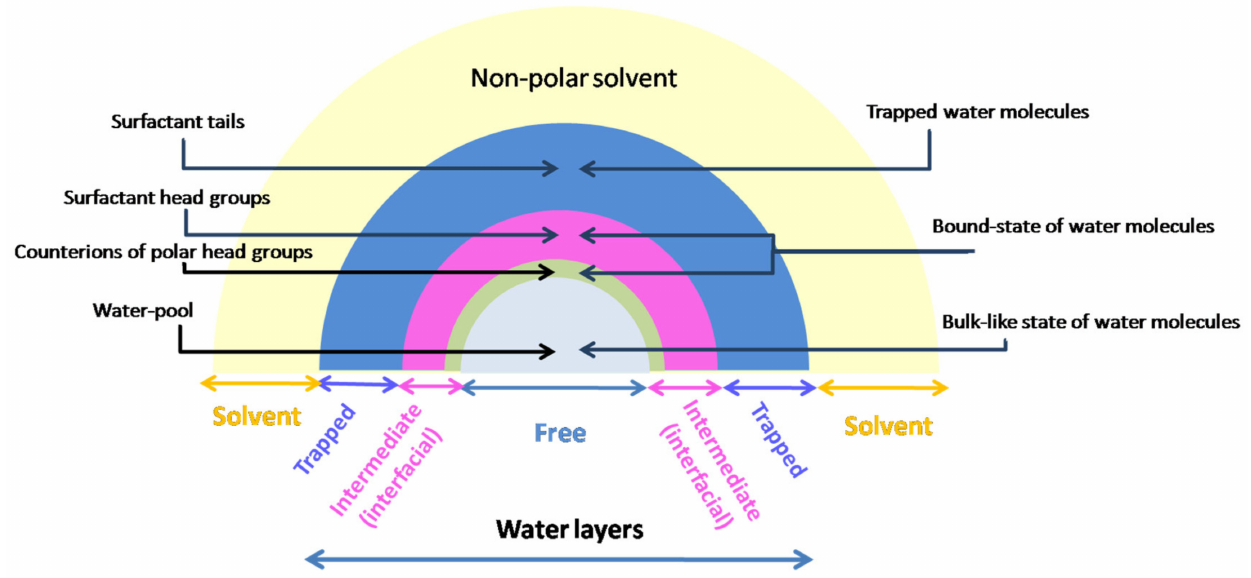
Figure 6. Correlation between the general structure of RMs and the multilayered structure of water inside